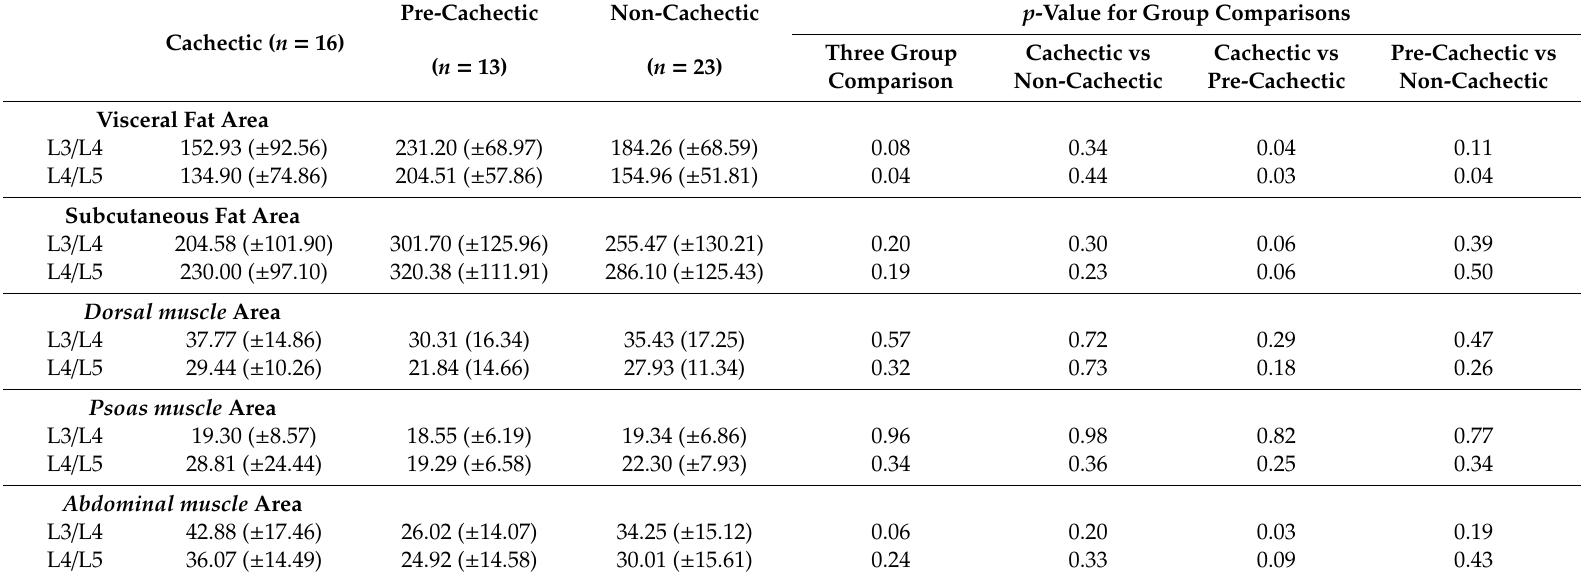
Table 3. Body composition at baseline in cachectic, pre-cachectic, and non-cachectic patients.